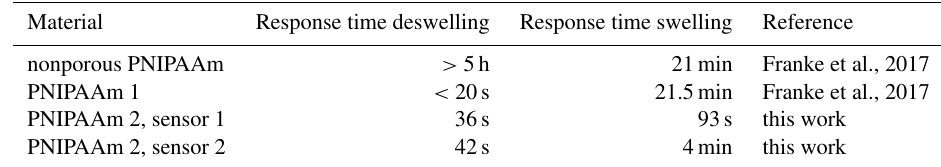
Figure 5. Results of the sensor measurements. Table 1. Comparison of the response